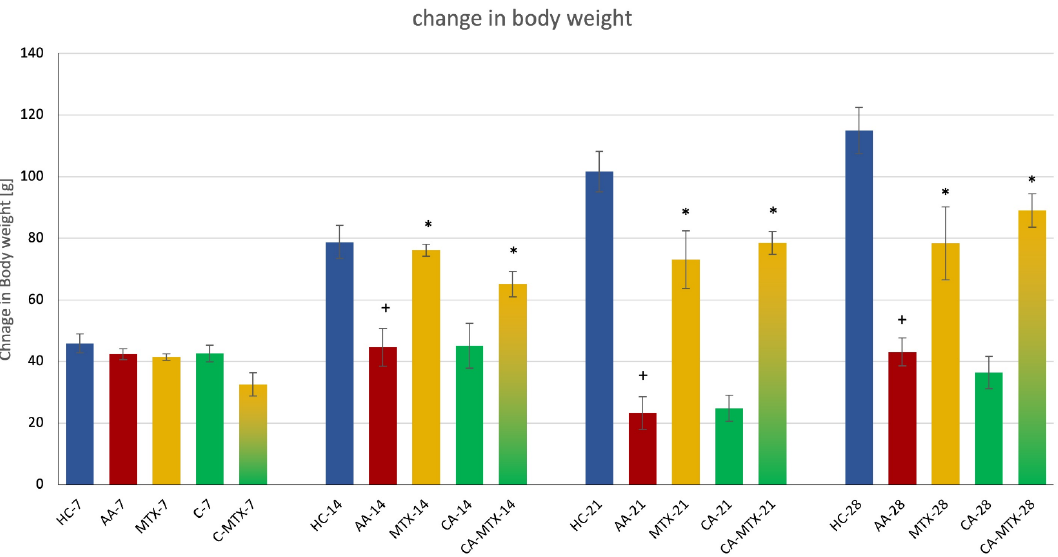
Figure 1. Change in body weight (day n (g) − day 1 (g) = increase in weight (g)) on the 7th, 14th, 21st, and 28th day. + HC vs. AA, * AA vs. MTX/CA/CA-MTX, p ≤ 0.05.